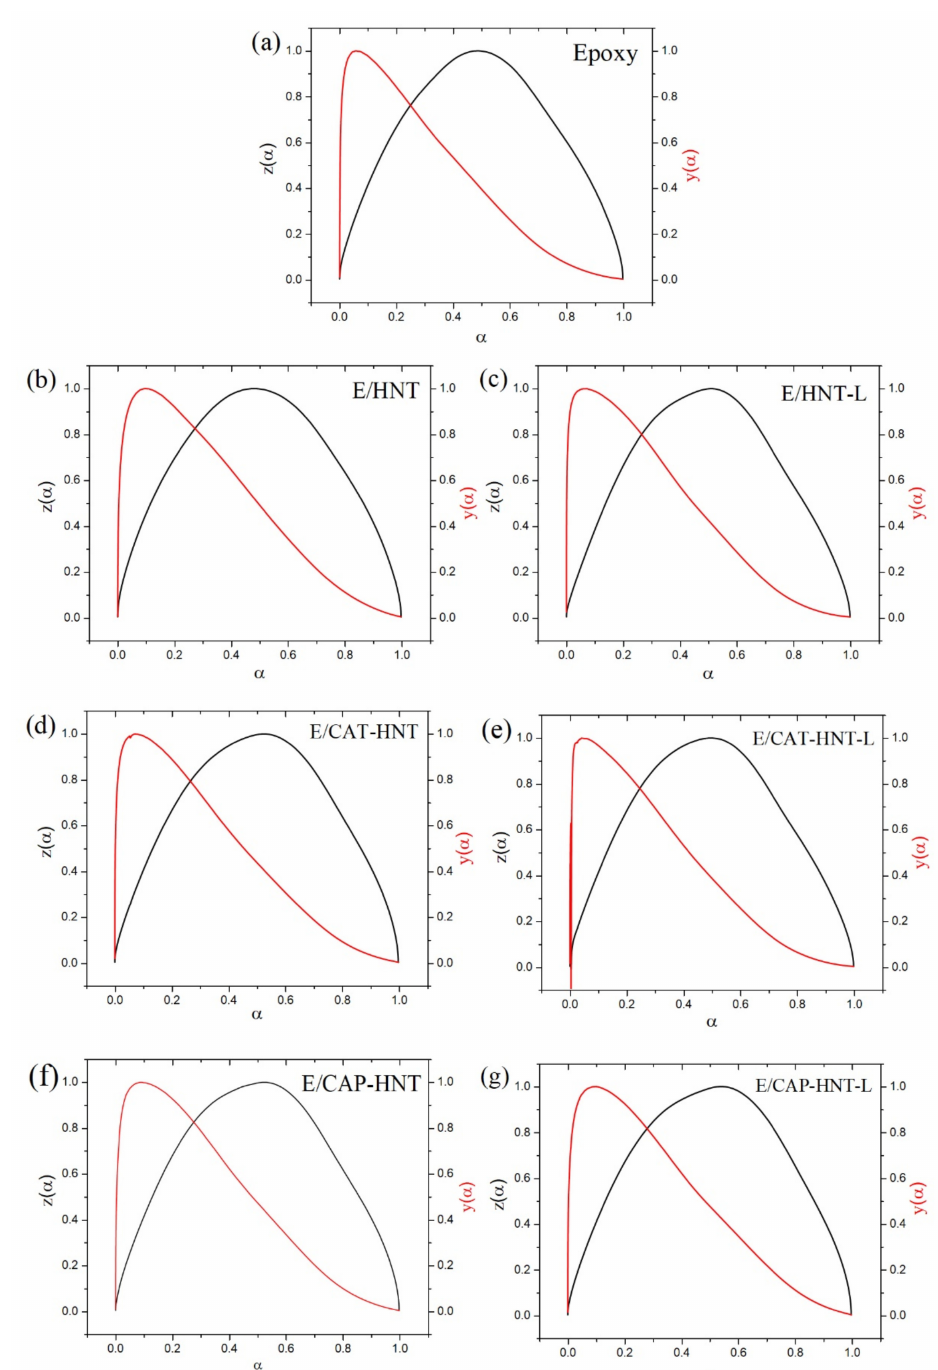
Figure A6. ( a – g ) Variation of y( α ) and z( α ) versus conversion for prepared samples based on Malek